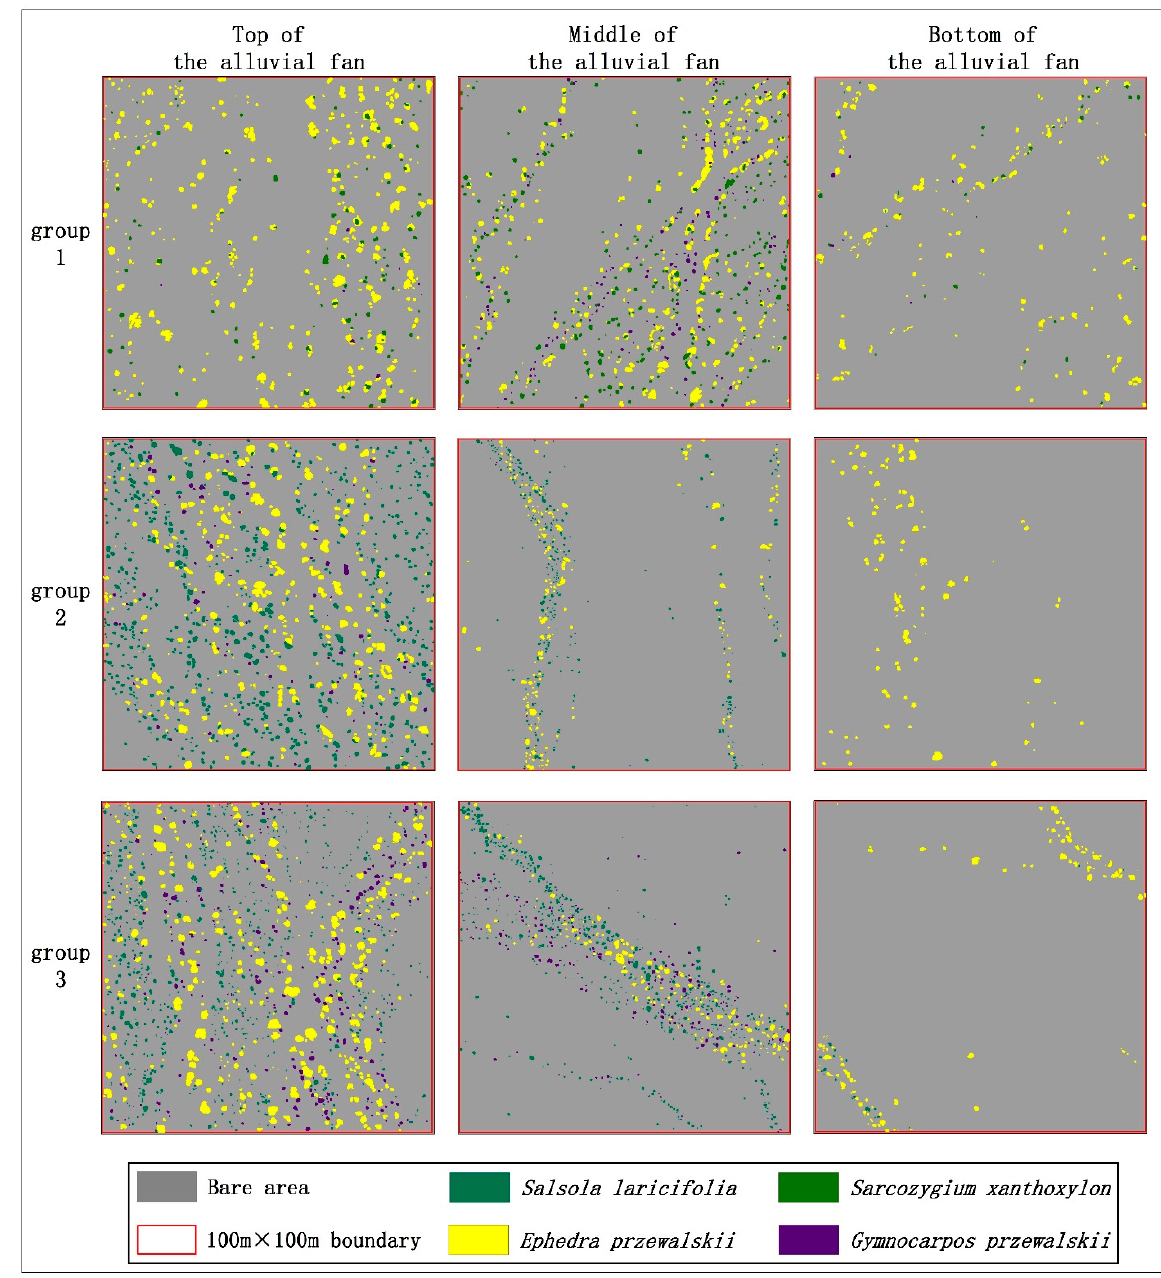
Figure 8. Spatial distribution of shrub species across different areas ( top , middle , and bottom ) of alluvial fans.